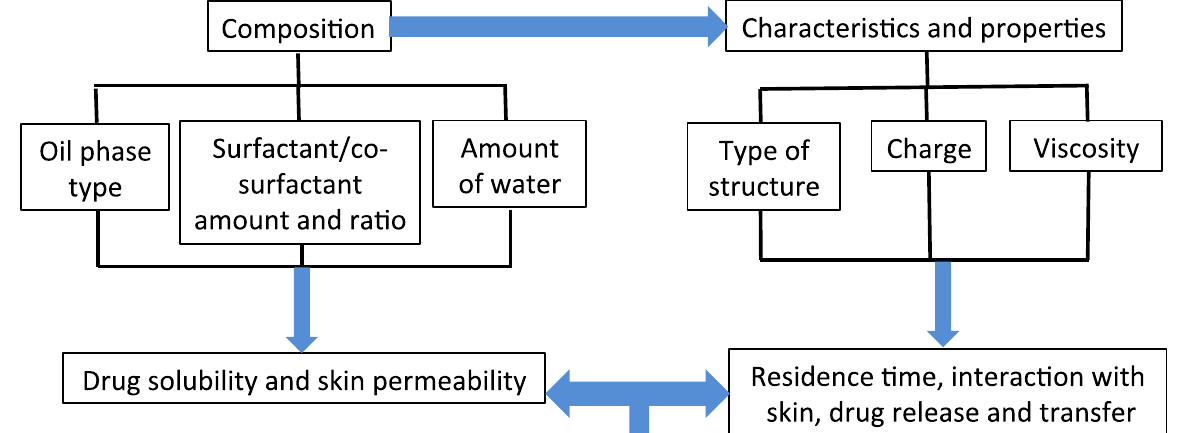
Figure 1. Microemulsion-related parameters influencing skin penetration and transdermal delivery of drugs and other active compounds. Depending on its